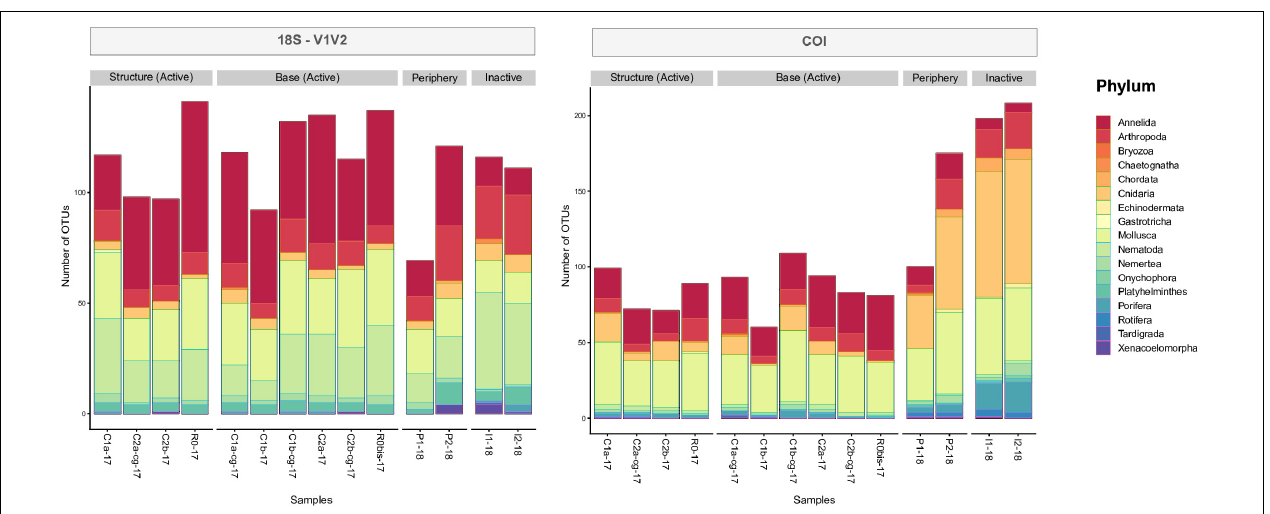
FIGURE 7 | Taxonomic characterizations of 18S-V1V2 and COI eDNA datasets by phylum, based on number of OTUs (incidence) and identified from samples distributed around the active edifice, periphery and inactive